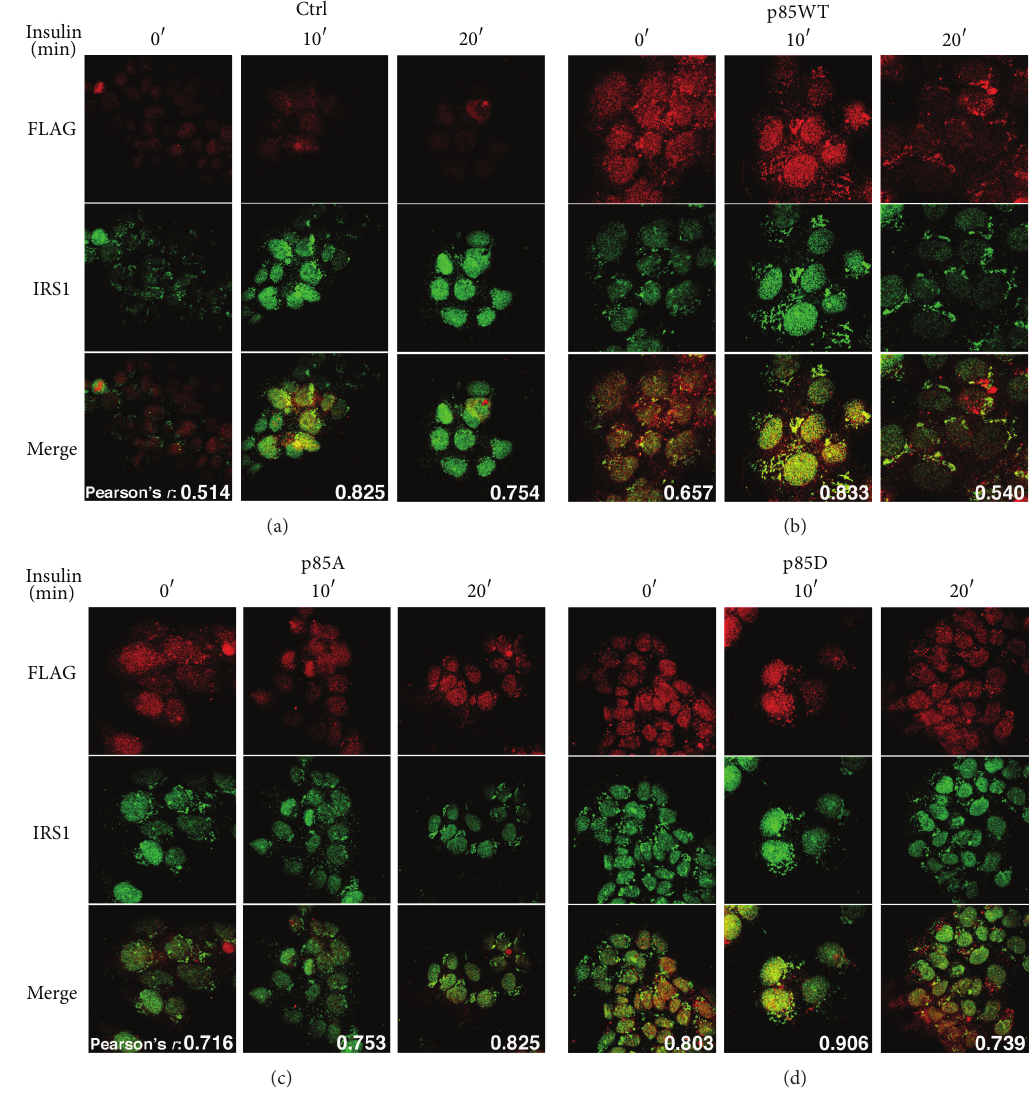
Figure 2: Role of phosphorylation of p 85𝛼 PI 3 K S83 in the subcellular localization of p85 𝛼 and IRS-1. MCF-7 cells transiently transfected with p85WT or p85A or p85D were seeded on 12mm glass coverslips, with serum starved for 6h and treated with 10 nM insulin for 10 and 20 minutes.Asinternalcontrolcellsweretreatedfor30minuteswithFBS.ImmunofluorescencestainingwasperformedasdescribedinMaterials and Methods. After incubation cells were fixed, permeabilized, and stained with anti-FLAG and anti-IRS-1 antibodies. Pearson’s coefficient is shown in each panel, overlapping images and Van Steensel’s cross-correlation functions (CCFs) were calculated for each experimental point (see Figure S1B). Transfection efficiency was determined by flow cytometry using anti-FLAG antibodies (seeSection 2) and is shown in Figure